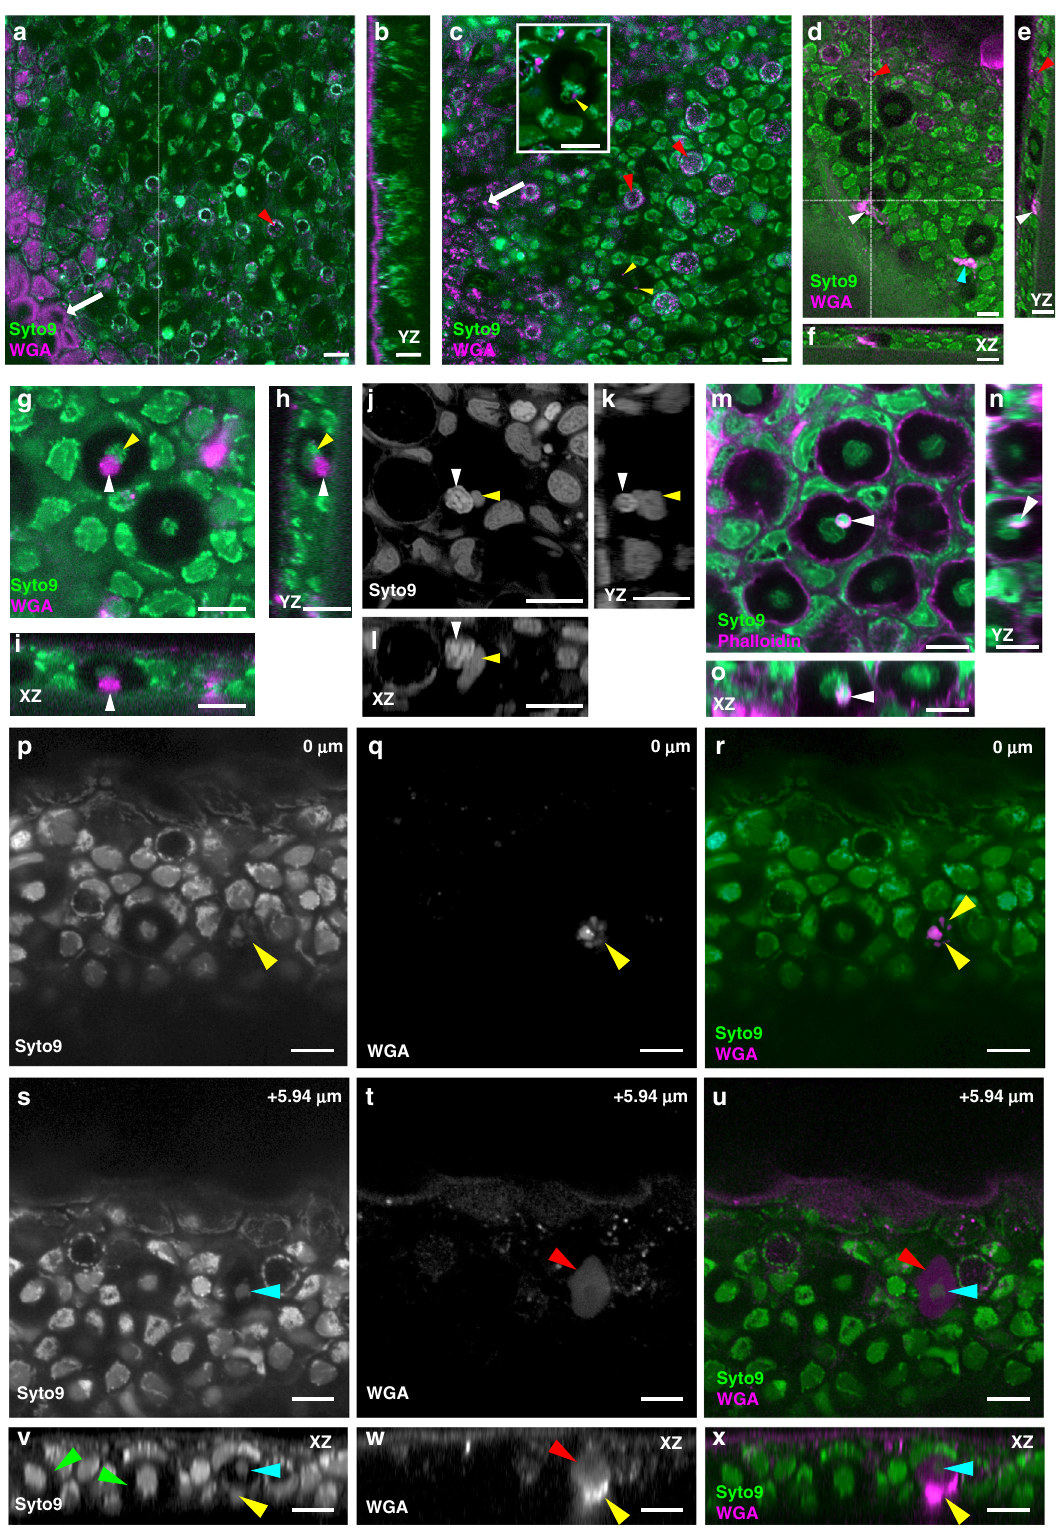
been labeled with a fl uorescent dye pHrodo Red. The following day, punctate label was found in surface epithelial cells, goblet cells, neutrophils and club cells (Fig. 3a – e; n = 6 fi sh). Diffuse label was detected throughout the cytoplasm of a subset of club cells in all fi sh imaged (11.6% ± 6.6%; average ± standard deviation; n = 596 cells; Supplementary Fig. 4; Fig. 3a;